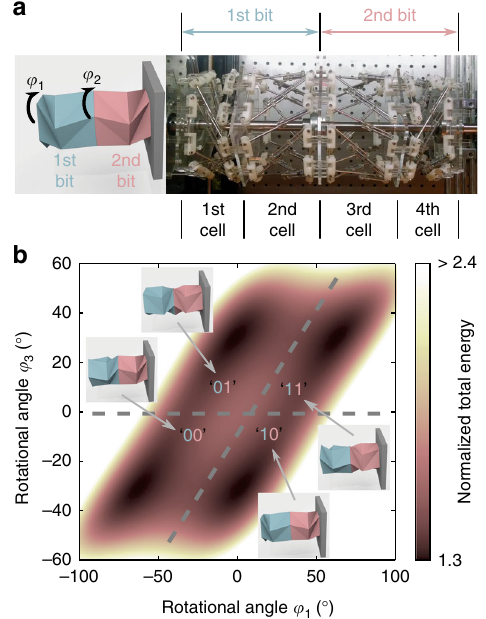
Fig. 4 Two pairs of TCO cells ’ to construct two-bit memory. a Two-bit memory is composed of four TCO-based unit cells as shown in a schematic illustration ( left ) and photograph ( right ). The fi rst two units from the left (i.e., left pair in blue color ) form a fi rst bit, and the other two unit cells (i.e., right pair in red color ) form a second bit. The states of these two bits are determined by the rotational angles of the fi rst and third unit cells, φ 1 and φ 3 . b The potential energy of the system as a function of analyzed, where a darker region represents a lower level of the normalized potential energy (color map). We divide the φ 1 and φ 3 space into four regions: ‘ 00 ’ , ‘ 01 ’ , ‘ 10 ’ , and ‘ 11 ’ . Inset illustrations indicate a representative shape of the TCO cells for each